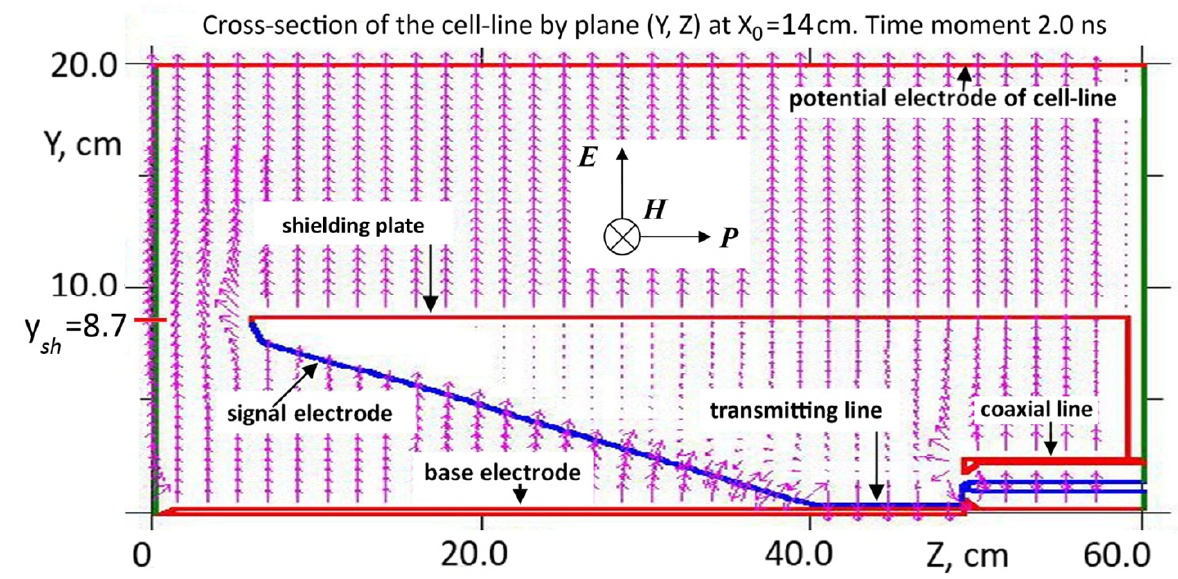
Figure 4. Schematics of antenna 2 in the ( Y , Z )-plane at x 0 = 14 cm in the simulated cell-line, with an external EM wave moving from the left window. The blue lines are the profiles of the signal electrodes. The arrows are the schematic drawing of the E -field vectors at time 2 ns.